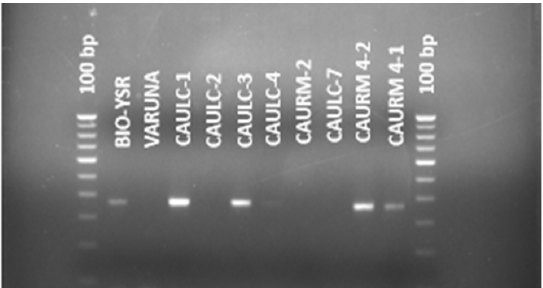
Figure 4. Genotyping of 10 B. juncea lines showing less than 10.83% PDI (Percent Disease Index) using marker BjuWRR1 -VD marker.